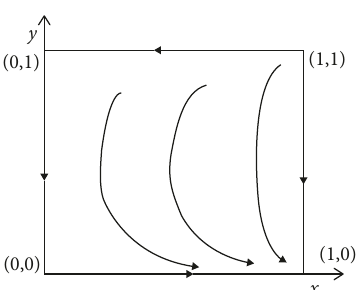
Figure 1: Replicated dynamic phase diagram of system 1 under condition (1).